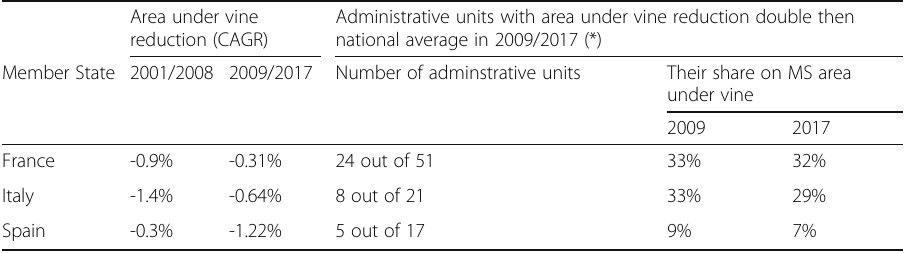
Table 6 Area under vine evolution: regional differences in selected EU Member States Area under vine reduction